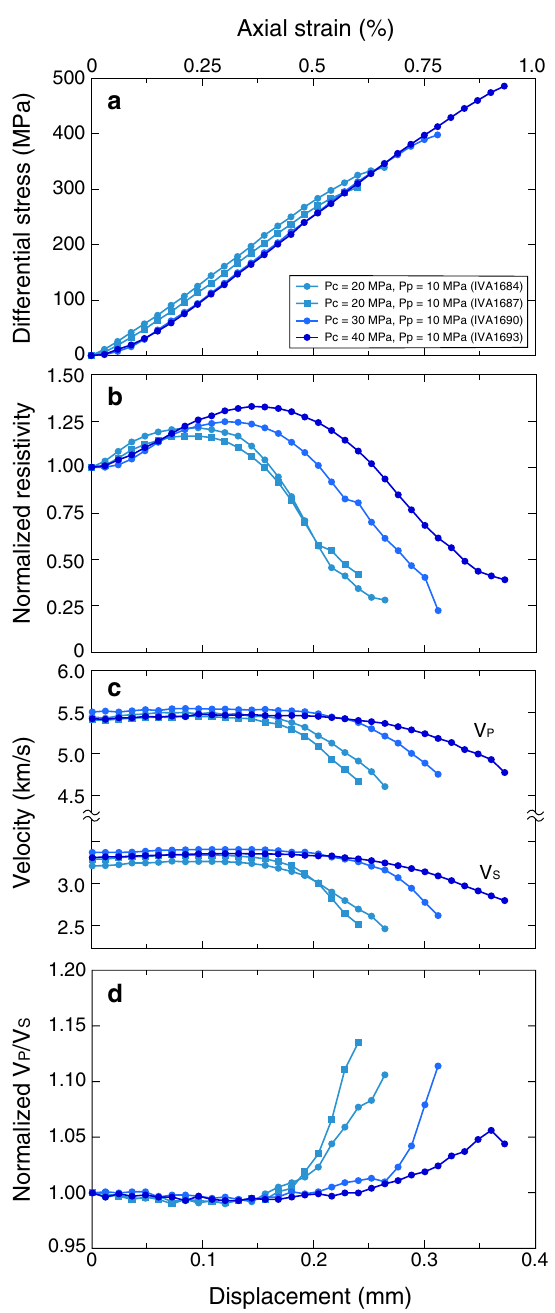
Fig. 3 a Stress and displacement curves for the experiments under brine-saturated conditions. The axial strain, which is inferred from the displacement, is also shown on the upper axis. b Electrical resistivity changes during deformation, which are normalized to the initial value prior to deformation. c Elastic wave velocity ( V P and V S ) changes during deformation. d V P / V S changes during deformation, which are normalized to the initial value prior to